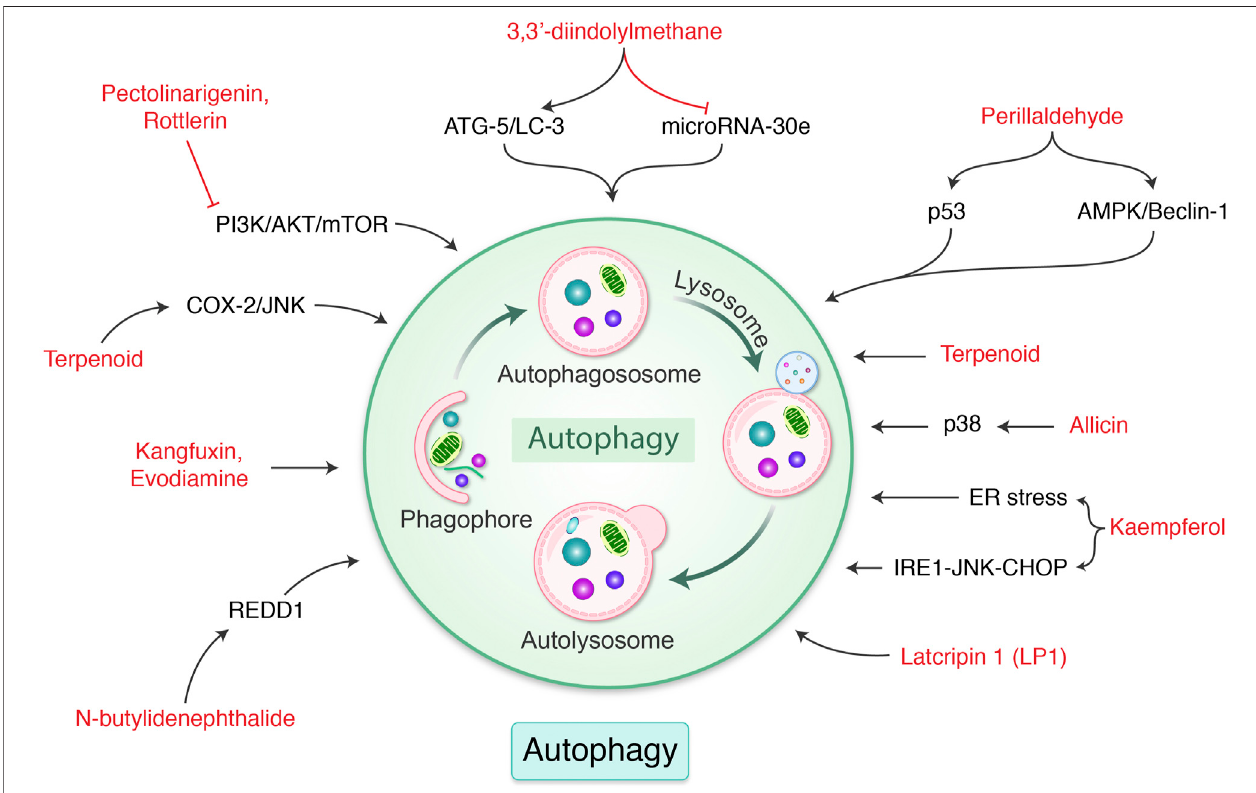
FIGURE 5 | Phytochemicals modulate autophagy-mediated cell death in gastric cancer. Differentnaturallyoccurring molecules are regulated ER stress, p38, p53, ATG gene, COX-2, and mTOR pathway, which modulate autophagy in gastric cancer. Each compound is well-described in the text.